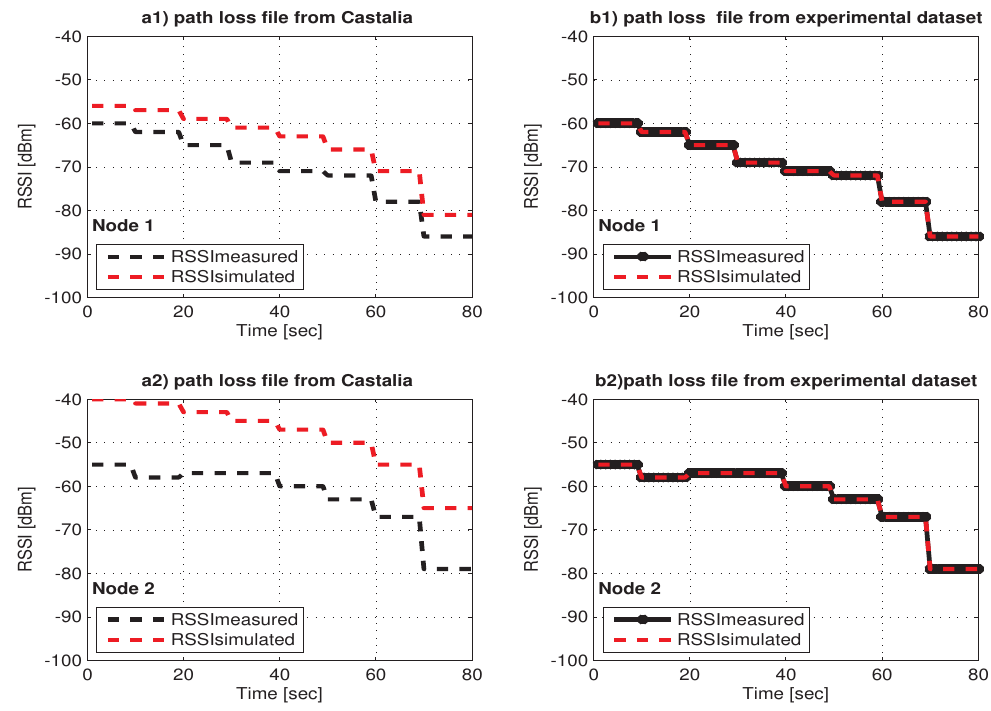
Figure 4. RSSI behavior using the path loss default file of Castalia vs . the path loss file from the experimental